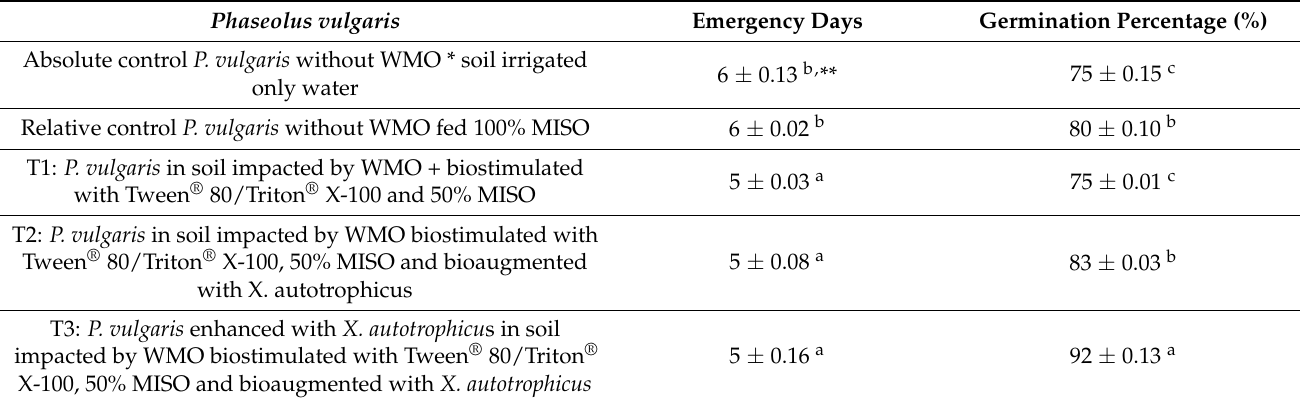
Table 3. Germination percentage and days to emergency of Phaseolus vulgaris enhanced with Xan- thobacter autotrophicus during phytoremediation of agricultural soil impacted by waste motor oil. Phaseolus